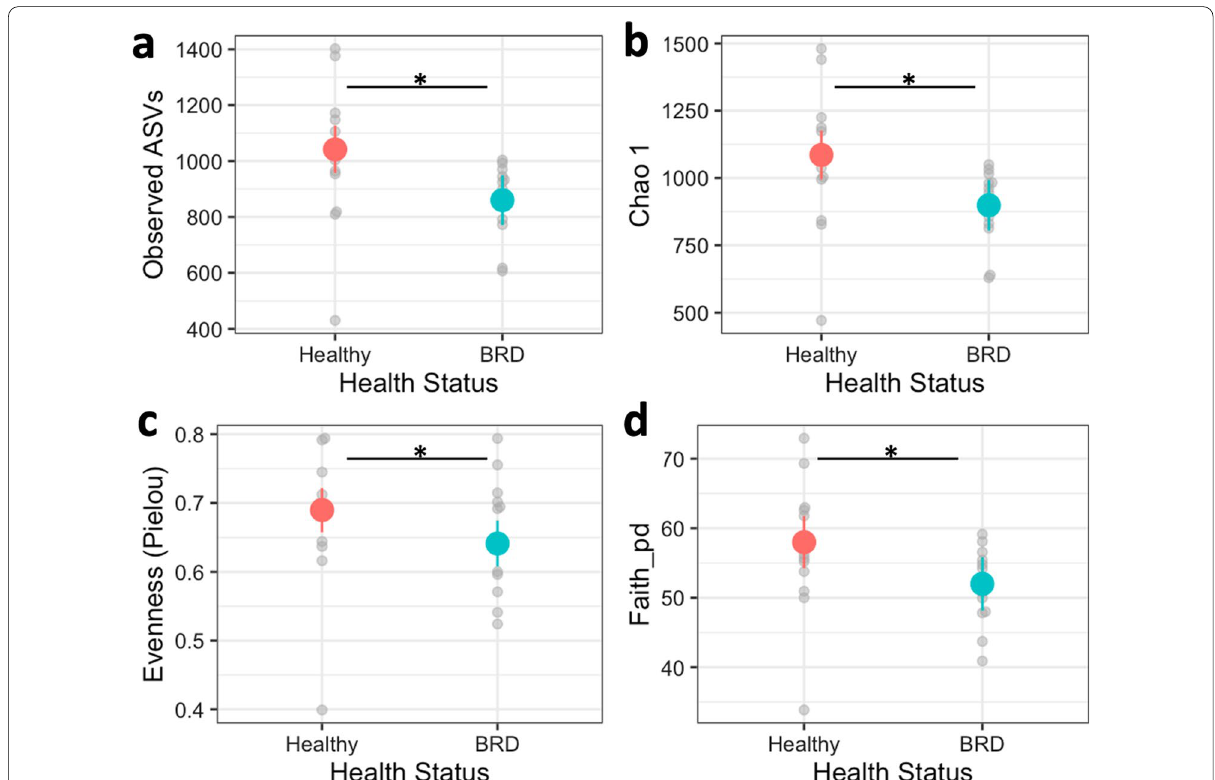
Fig. 1 Alpha diversity of the nasal microbiome in cattle that are apparently healthy or display BRD clinical signs (BRD). Observed ASVs ( a ) and Chao 1 ( b ) measure the richness of the microbiome community. Evenness was measured with Pielou ( c ), and the phylogenetic relationship was measured with Faith’s PD ( d ). An asterisk (*) and horizontal line represent a statistical difference ( p 0.05) between the two groups. Colored circles and lines ≤ represent the means and standard error of the BRD and healthy groups, respectively, and the gray dots represent the raw data of each